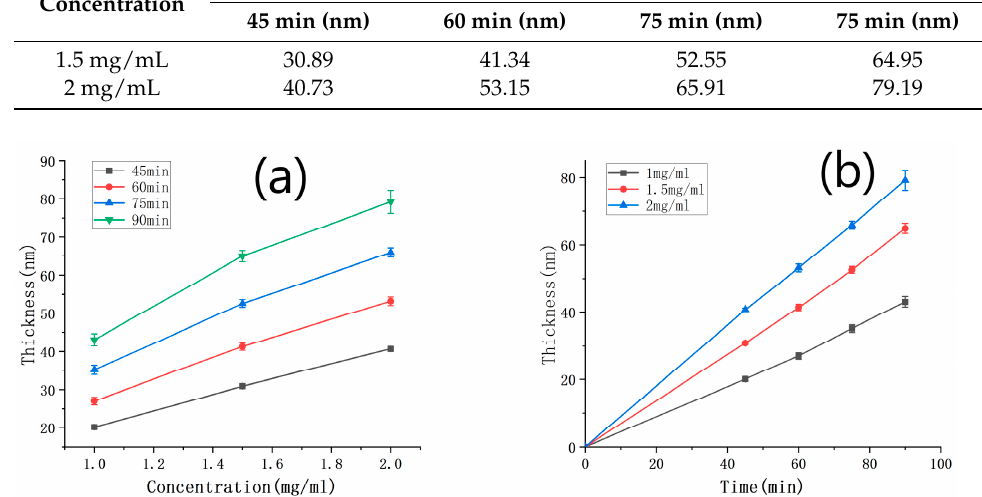
Table 2. Thickness of the PDA film deposited for different time. Concentration